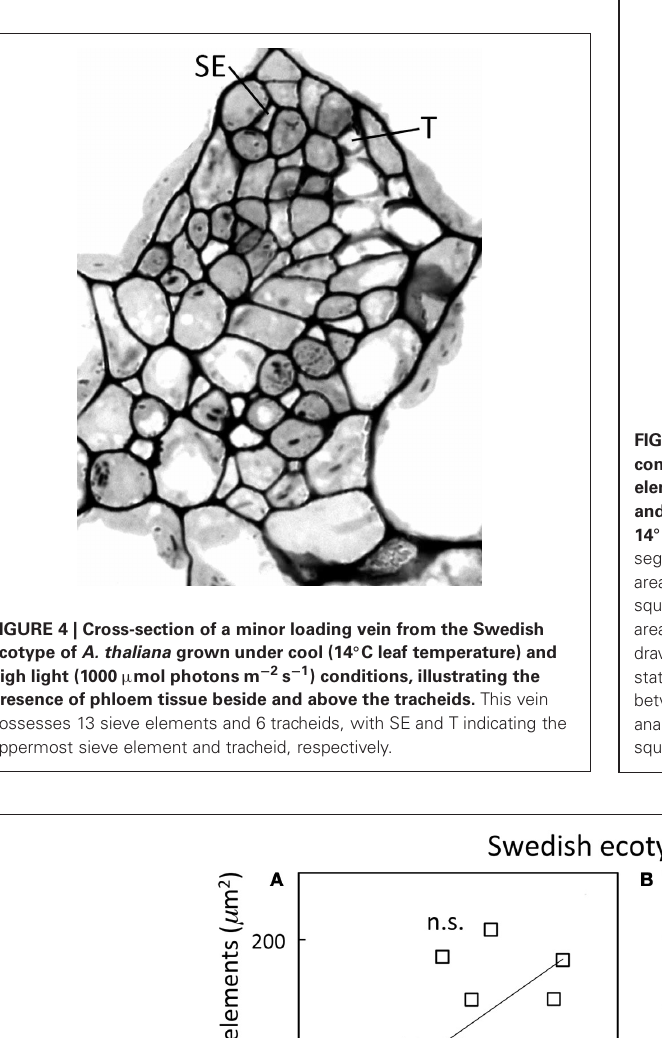
squares; second order veins). Linear regression lines drawn for each segregated group of veins ( ≤ 14 SEs or ≥ 15 SEs), and statistically significant differences in slope and intercept (ANCOVA) between regression lines is indicated (n.s. = not significant at P ≤ 0 . 05). Linear regression analyses for each line are ( A ) y = 0 . 12 x + 47, R 2 = 0 . 34, and P < 0 . 01 (black squares) and y = 0 . 14 x + 46, R 2 = 0 . 54, and P < 0 . 01 (open squares); ( B ) y = 0 . 03 x + 24, R 2 = 0 . 64, and P < 0 . 001 (black squares) and y = 0 . 04 x − 11, R 2 = 0 . 91, and P < 0 . 001 (open